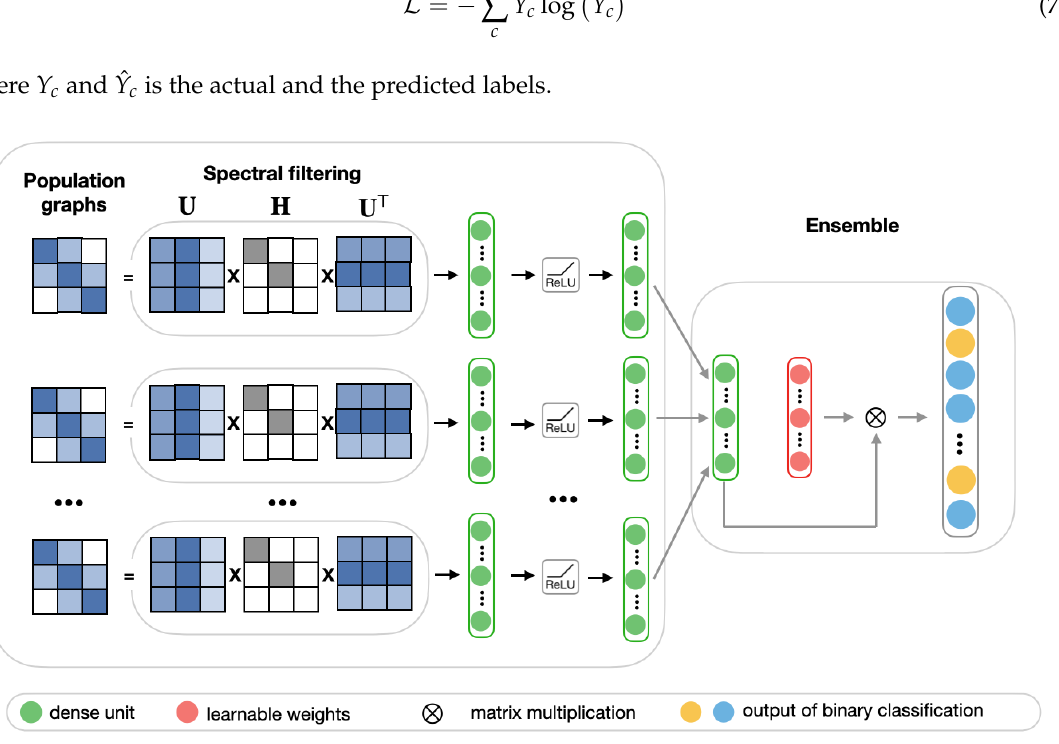
Figure 7. The schematic representation of the ensemble